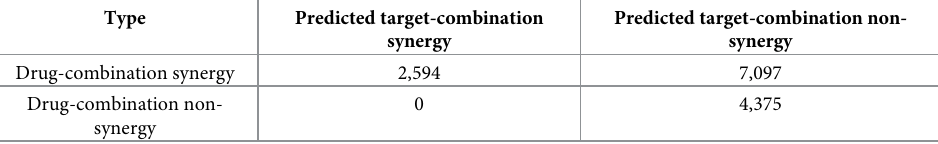
Table 3. Contingency table between drug- and target-combination